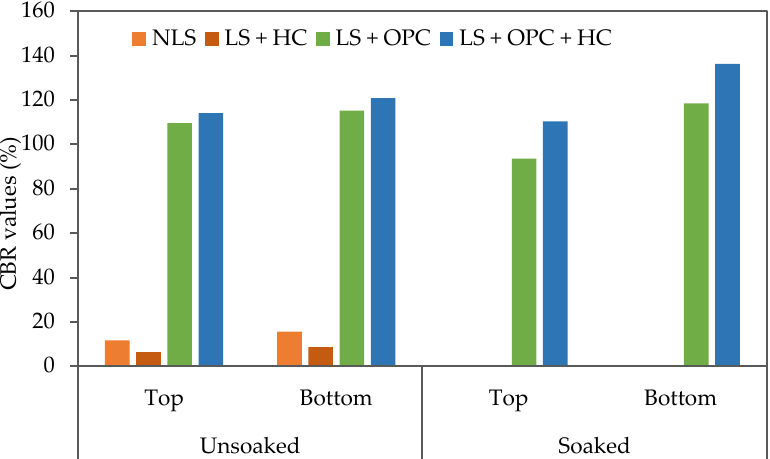
Figure 7. CBR of caltite – cement materials at a 7-day curing period with and without soaking under water.